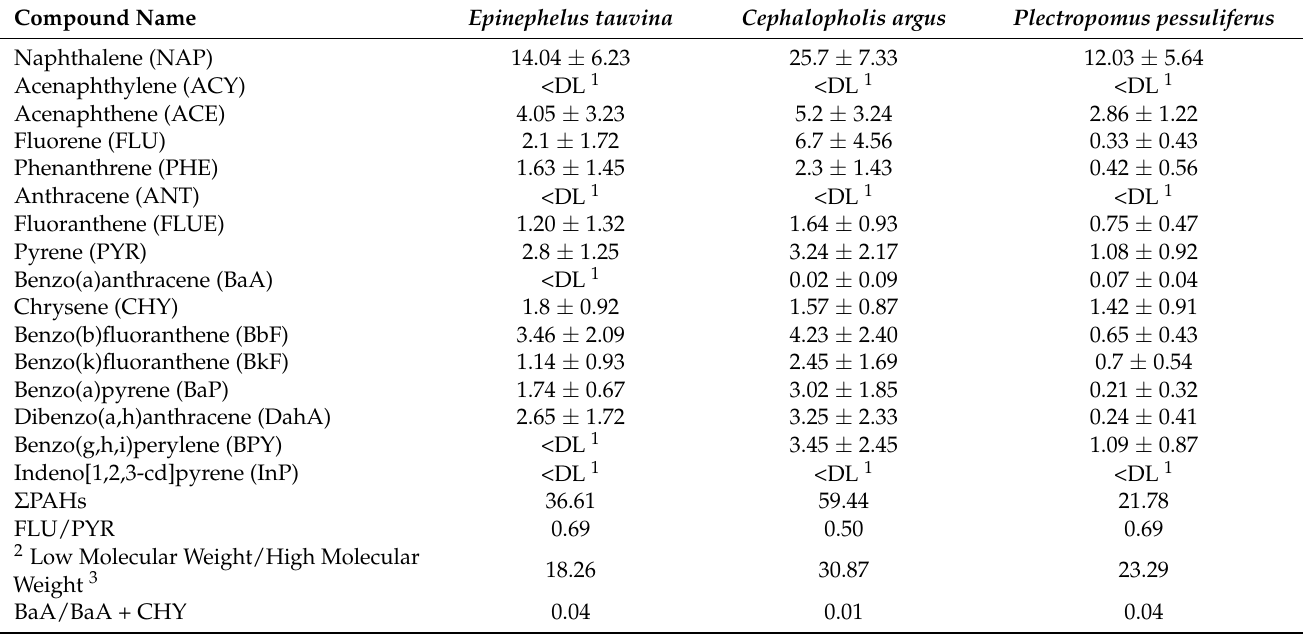
Table 8. PAHs concentrations (mean ± SD) and ratios in fish